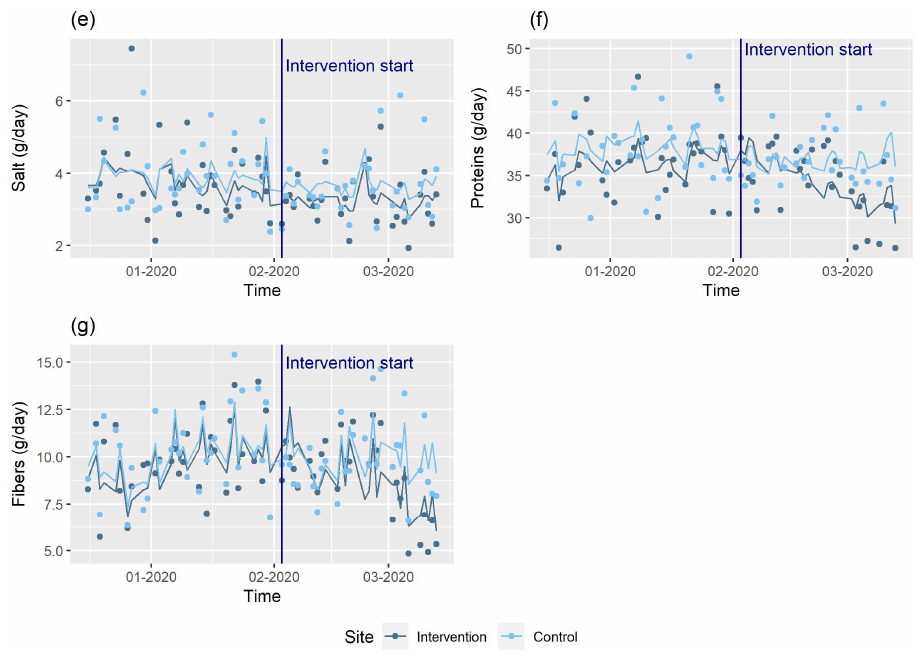
Figure 2. Observed and predicted dietary intakes over the study period for the intervention and control sites—Nutri-Score catering trial. ( a ) FSAm/HCSP score; ( b ) energy (Kcal/day); ( c ) saturated fats (g/day); ( d ) sugars (g/day); ( e ) salt (g/day); ( f ) proteins (g/day); ( g ) fibers